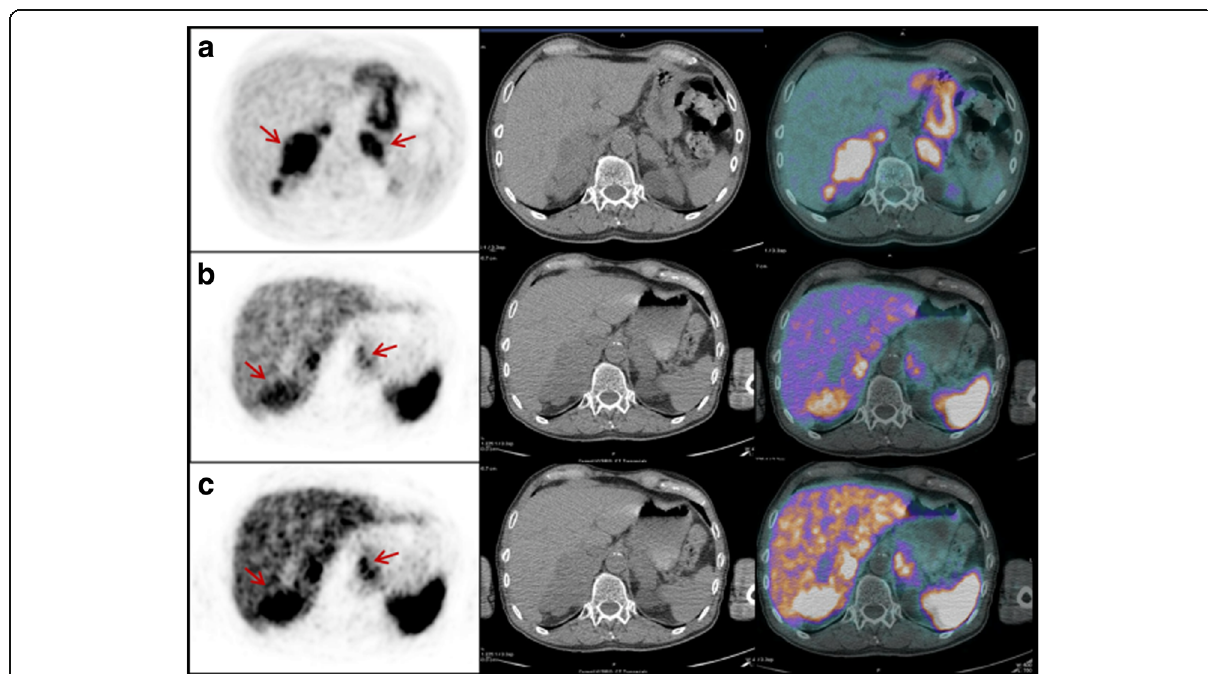
Fig. 2 PET/CT images performed for re-staging in patient #14. Transaxial 18 F-FDG ( a ) and 68 Ga-somatostatin analogs ( b , c ) at different intensity levels. PET/CT images showed abnormal tracer uptake in both adrenal metastatic lesions (red arrows). Both adrenals were enlarged (right > left). The pattern of uptake was inhomogeneous with both 18 F-FDG and 68 Ga-somatostatin analogs and, in the whole, a “ reverse ” and complementary distribution of uptake was evident with the two tracers, with clearly parts of the tumor that take up one or the other tracer (e.g., the “ hottest ” part of the right adrenal at 18 F-FDG appears substantially “ cold ” at 68